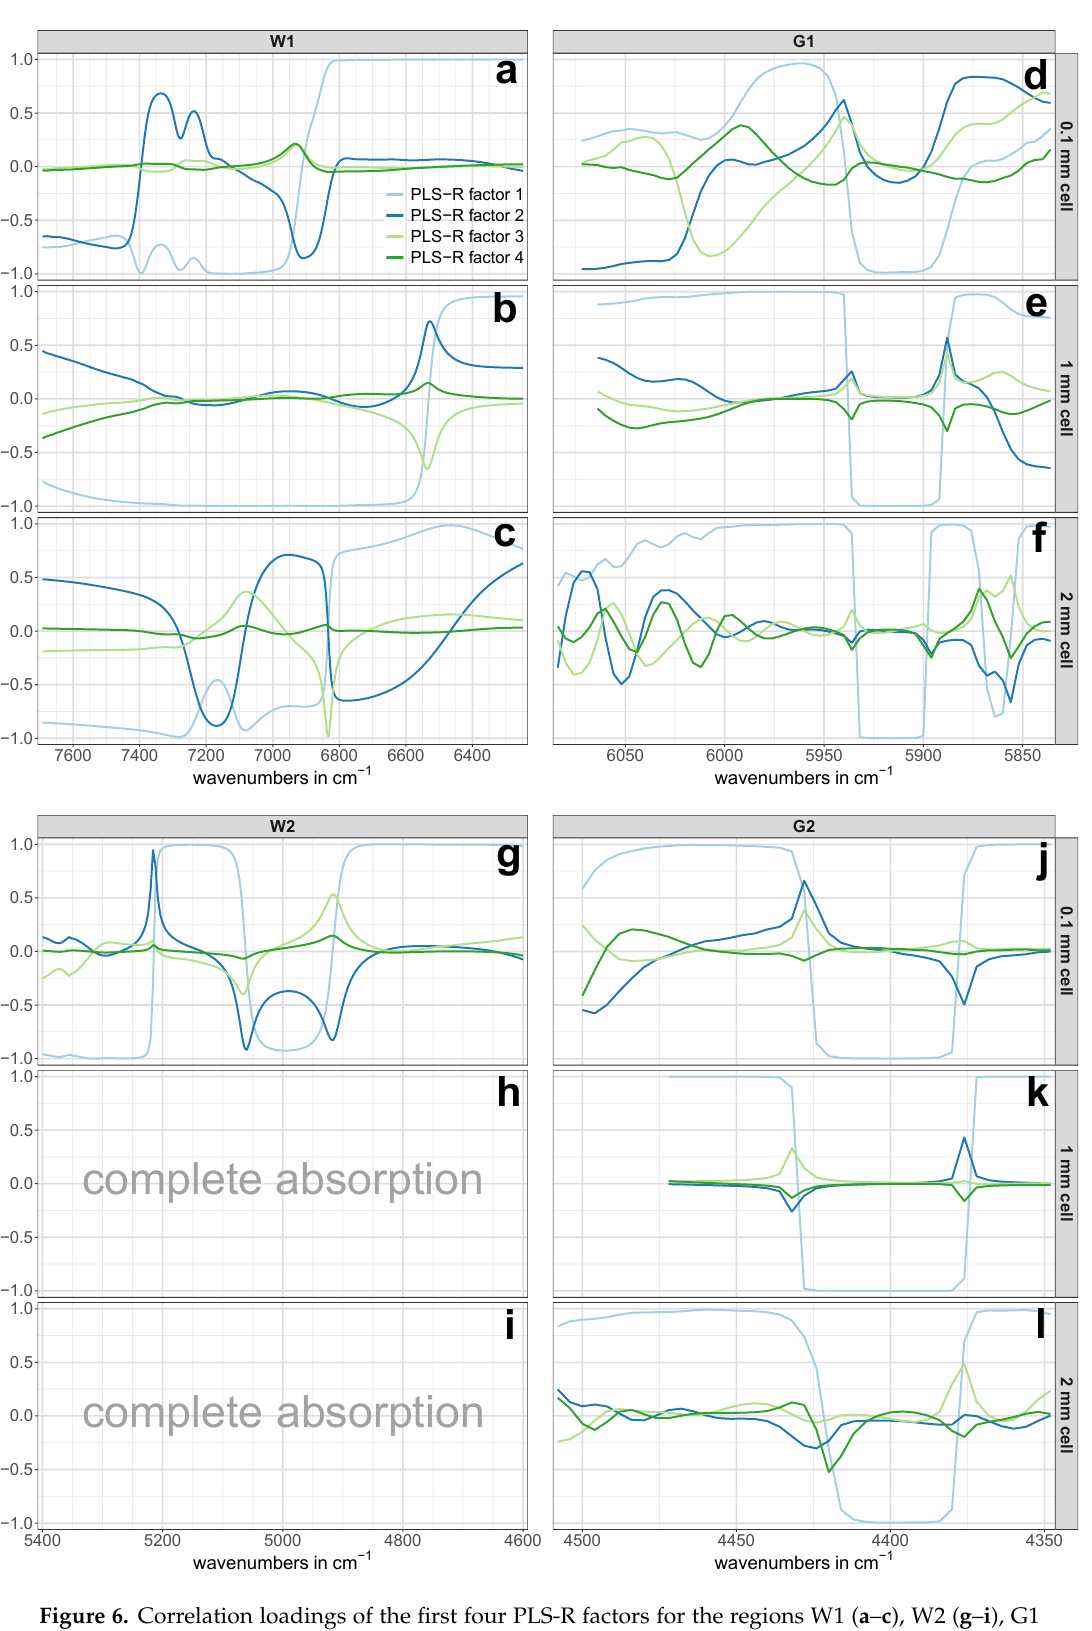
Figure 6. Correlation loadings of the first four PLS-R factors for the regions W1 ( a – c ), W2 ( g – i ), G1 ( d – f ), and G2 ( j – l ) with the corresponding cell